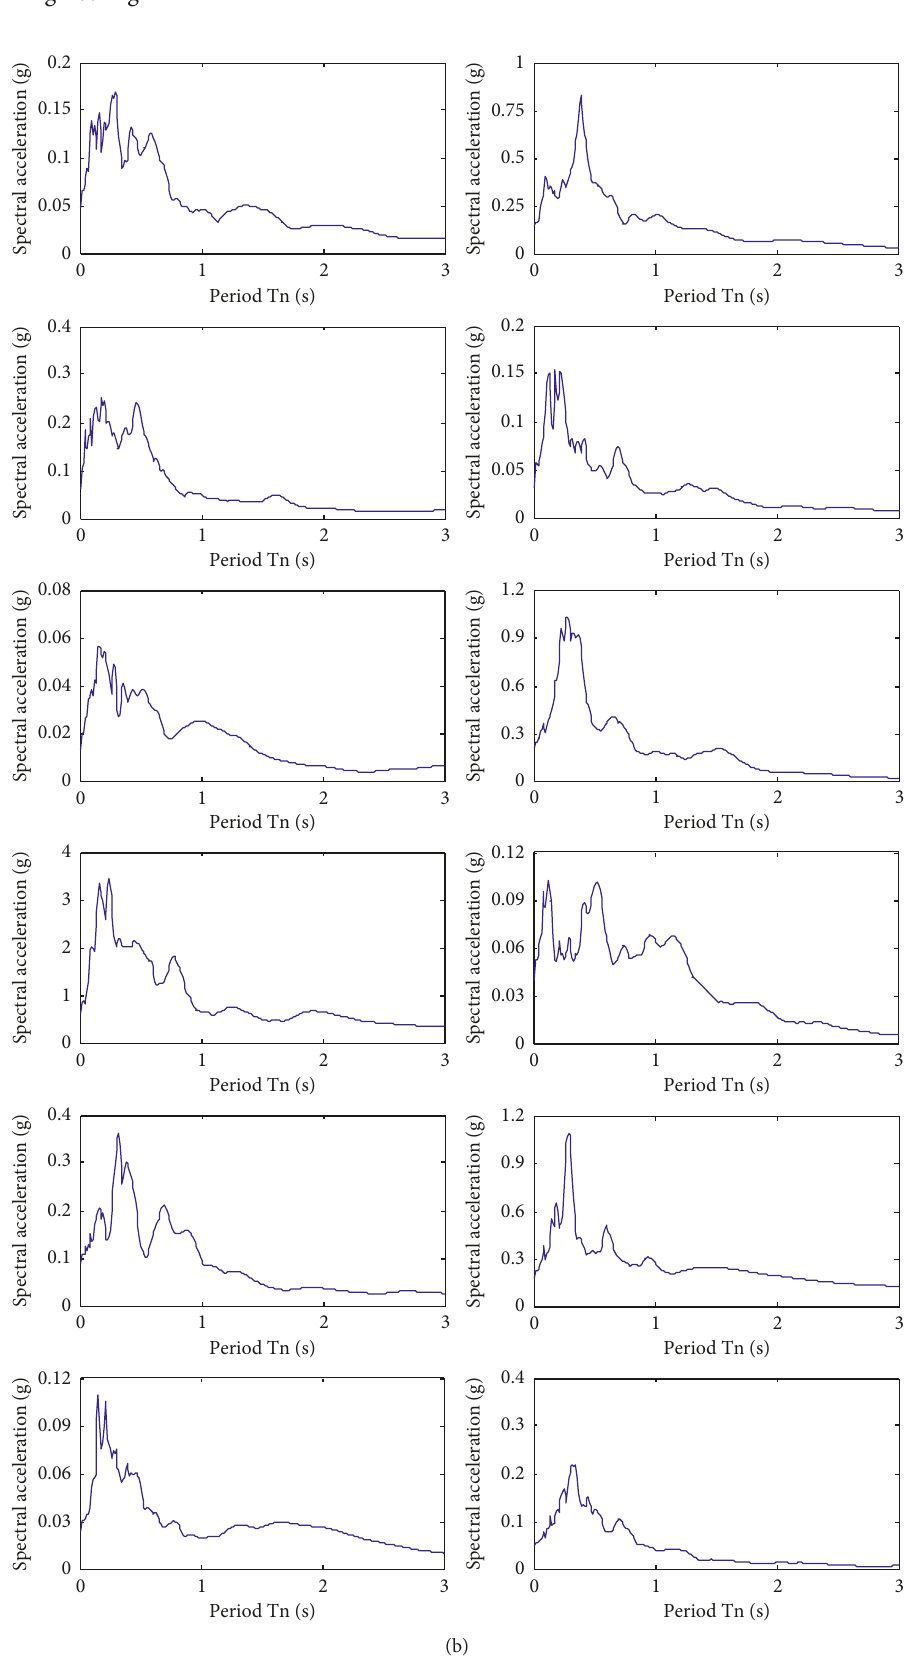
Figure 5: 12 actual and unscaled earthquake accelerations. (a) Acceleration time history. (b) Response